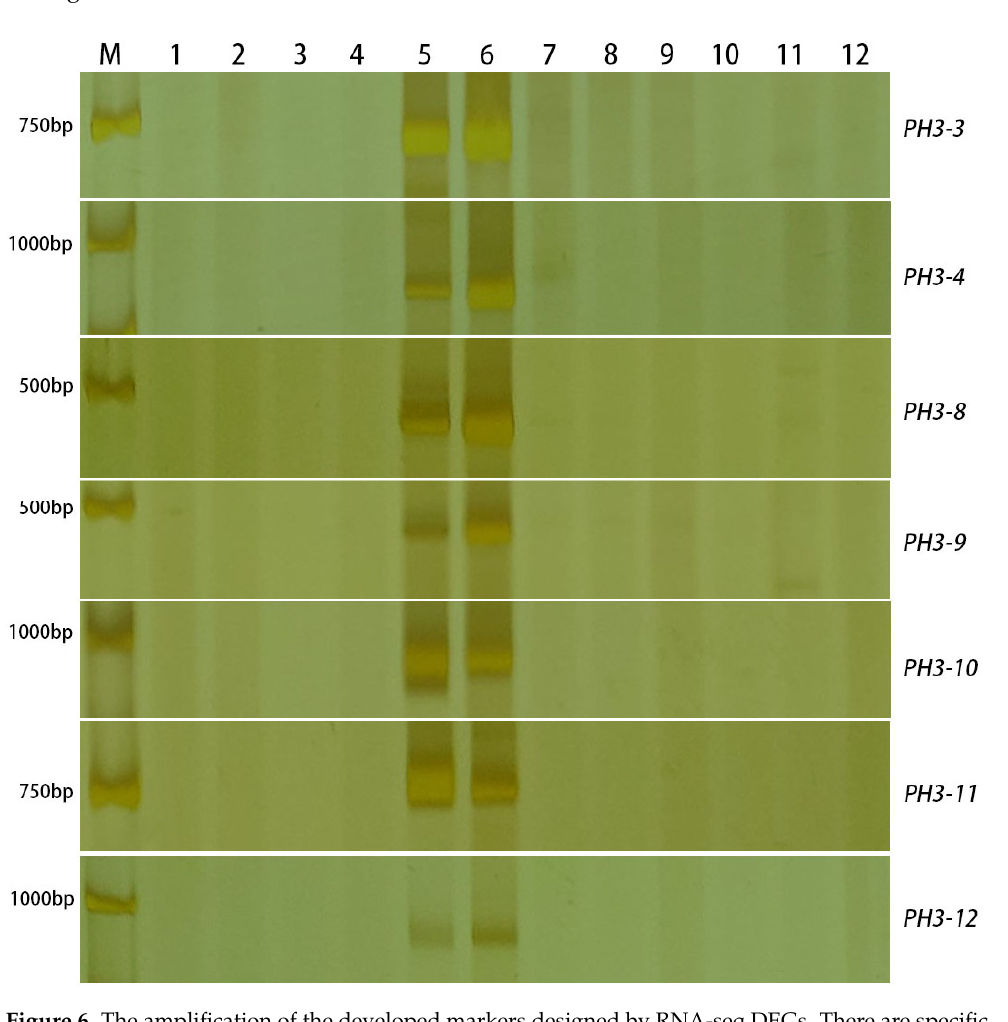
Figure 5. Transcriptome analysis of DEGs and analysis of 20JH1155 and 7182 in coregulate and ex- pression. ( A ) Each sample has a number of genes with FPKM values of more than 0.3 from 52,110 to 58,702. ( B ) Venn-diagram of gene expression of 20JH1155 and 7182. ( C ) Venn diagram of poten- tially exogenous genes of 20JH1155 in three-time points. ( D ) GO enrichment analysis with potential alien genes expressing 2413 at all three time points. (E) The heatmap of annotated DEGs in the brown module of 18 samples. ( F ) An upset plot of DEGs overlapped in the three datasets.